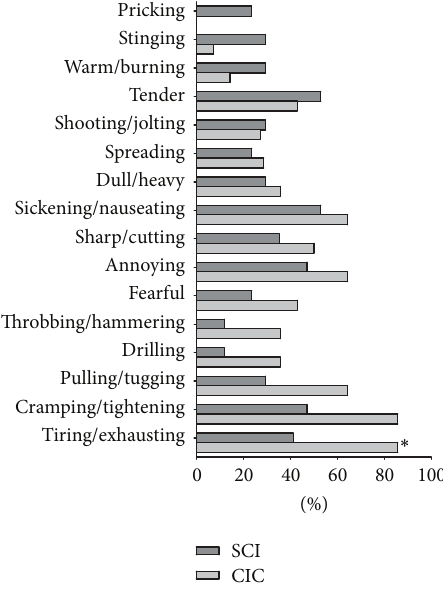
Figure 1: The Brief Danish Pain Questionnaire